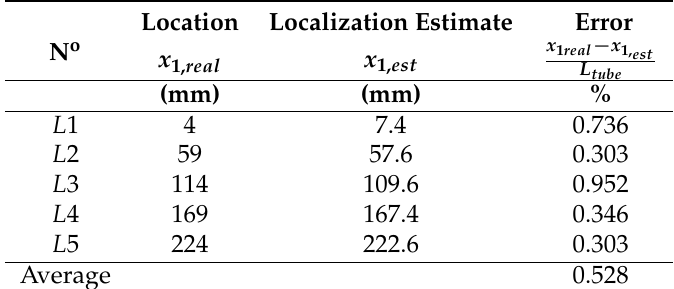
Table 1. Localization feasibility on basis of time-of-arrival of the negative pressure waves using the least squares analysis. ( L tube = 462